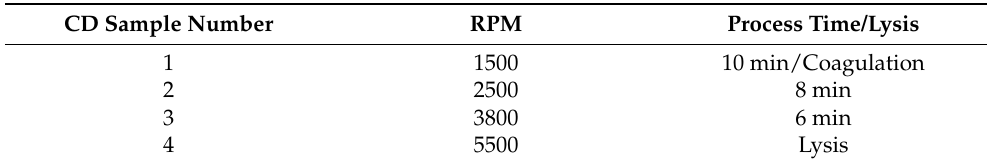
Table 3. Optimization of the angular velocity of the disc (in revolutions per minute) for blood plasma separation